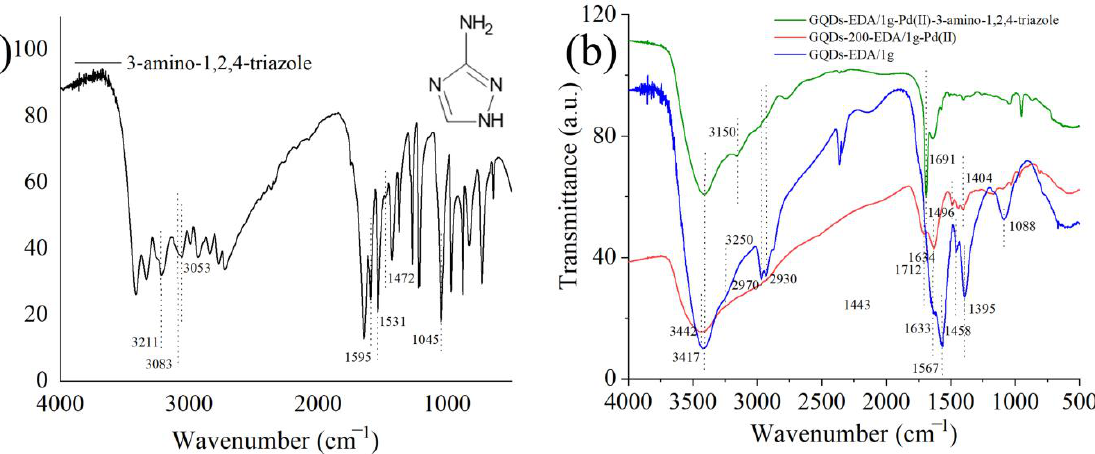
Figure 15. FTIR spectrum and structure of 3-amino-1,2,4-triazole ( a ), and FTIR spectra of GQDs-EDA/1 g, GQDs-EDA/1 g-Pd 2+ , and GQDs-EDA/1 g-Pd 2+ -3-amino-1,2,4-triazole ( b ).